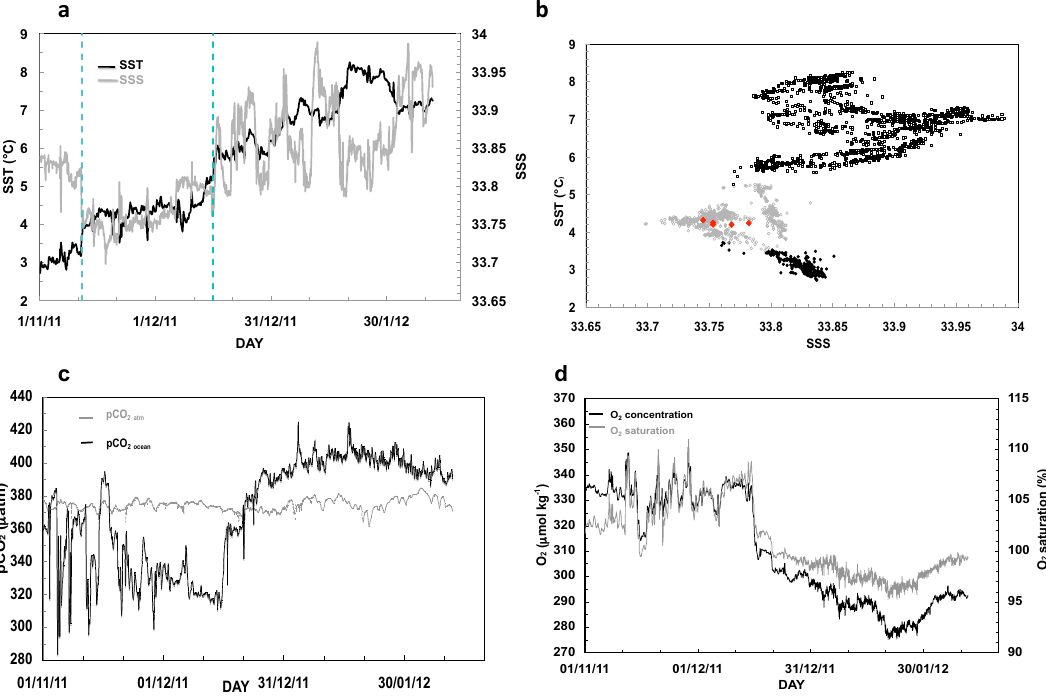
Figure 5. Buoy data from 1 November 2011 to 12 February 2012. (a) Temperature in ◦ C (black, left vertical axis) and salinity (grey, right vertical axis). (b) Temperature–salinity diagram: 1 to 11 November, black diamonds; 12 November to 16 December, grey diamonds; 17 December to 12 February, black squares. (c) p CO 2 measured at a depth of 2m in µatm (black) and in the atmosphere in µatm (grey). (d) Dissolved oxygen concentration measured at a depth of 2m in µmolkg − 1 (black, left vertical axis) and oxygen saturation in % (grey, right vertical axis). In Fig. 5a, the cyan dashed lines indicate 12 November and 16 December (see text). In Fig. 5b, the red dots indicate the data measured at the KEOPS2 stations TEW7, TEW8,